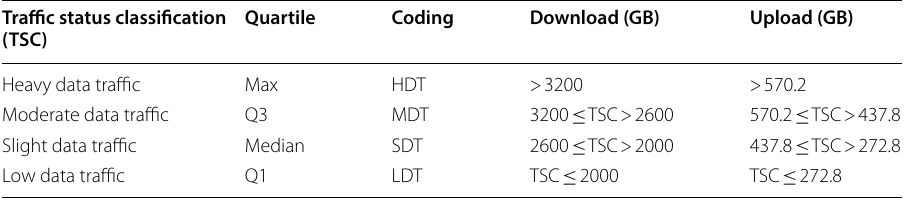
Table 1 Internet data traffic